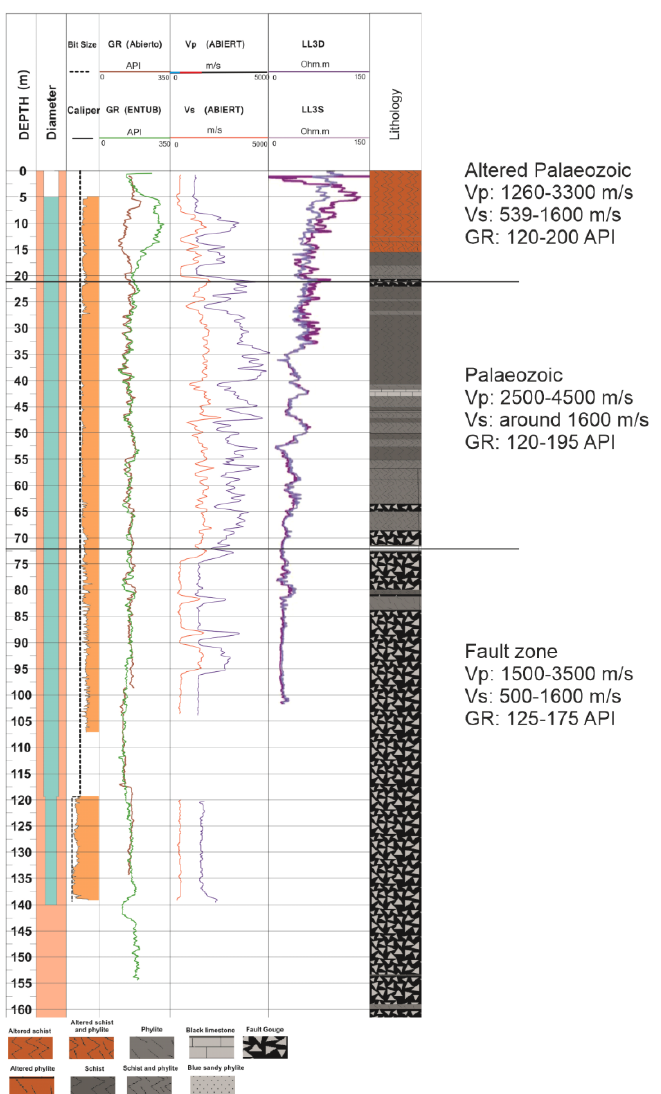
Figure 3. Gamma ray (GR), P-wave velocity (Vp), S-wave velocity (Vs), and resistivity logs recorded in the FAM-1 borehole (location in Figure 2C).